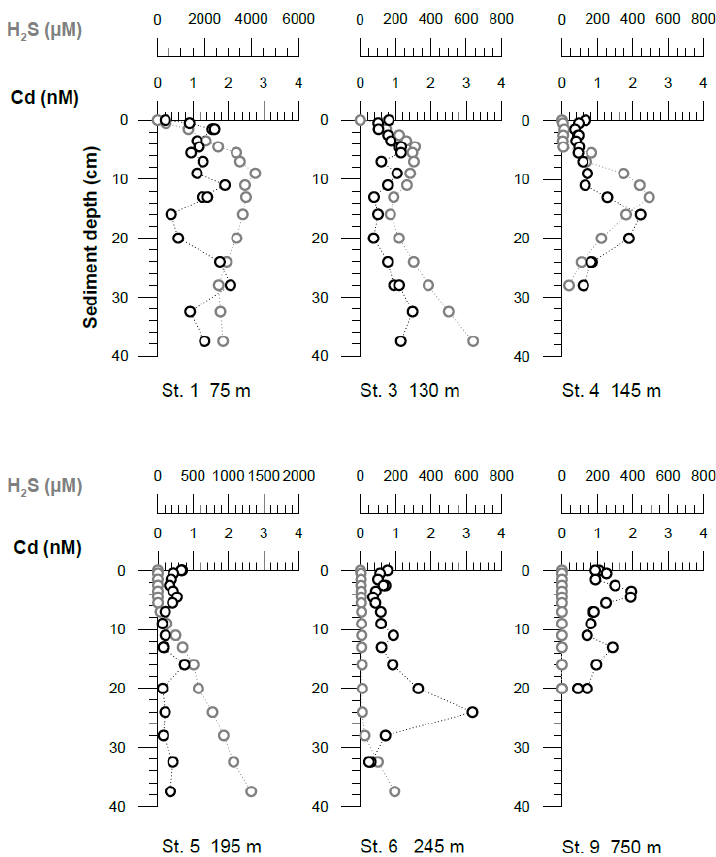
Figure 6. Pore water dissolved Cd and H 2 S concentrations. The uppermost sample represents the bottom water concentrations. The analytical error is smaller than the symbol